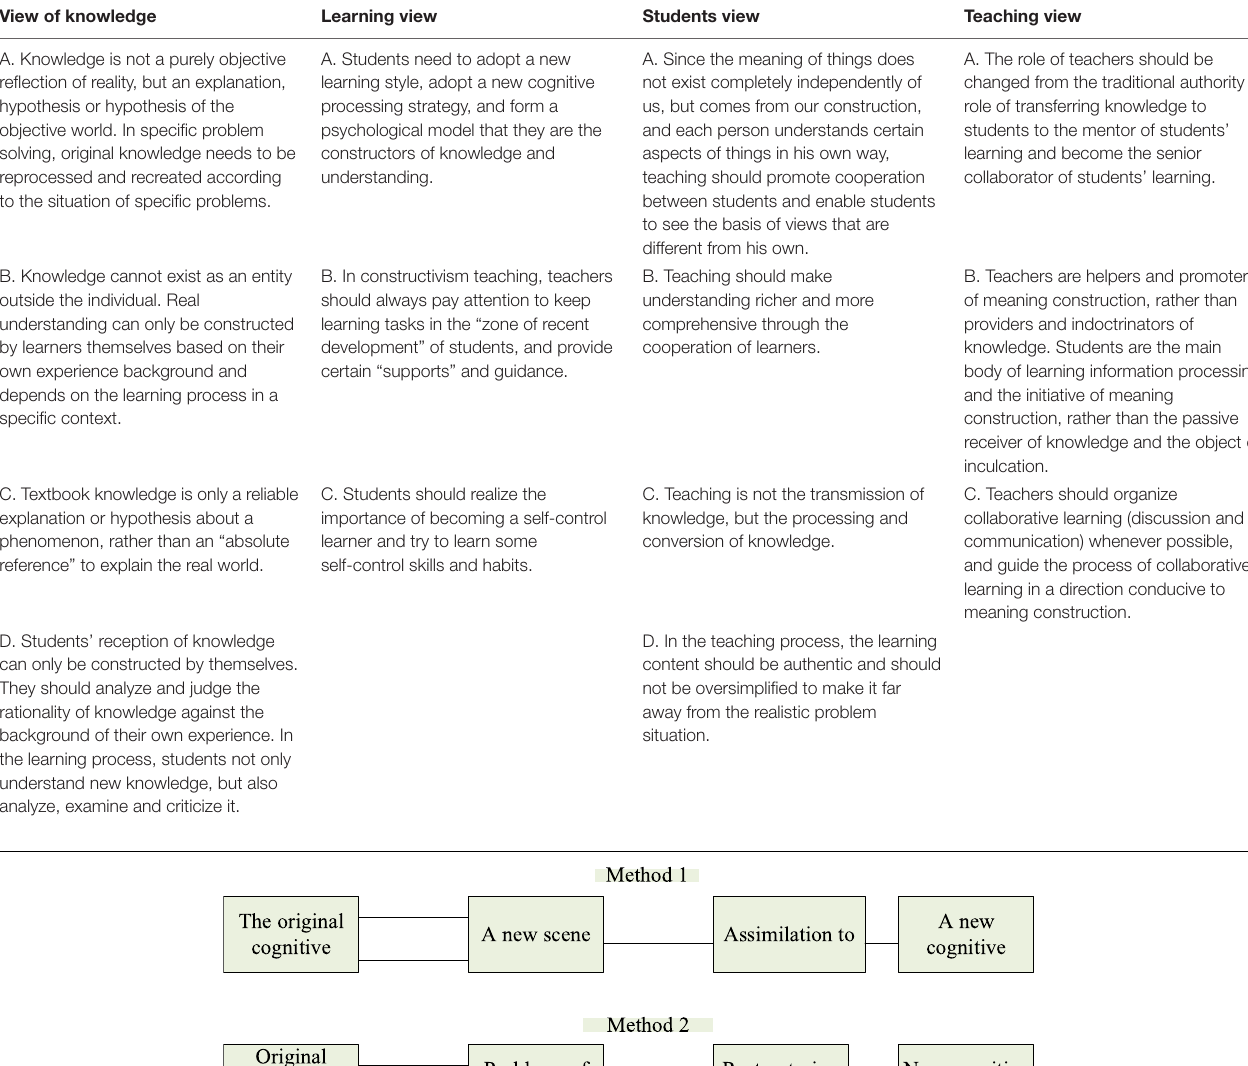
TABLE 3 | Constructivists’ views on education.